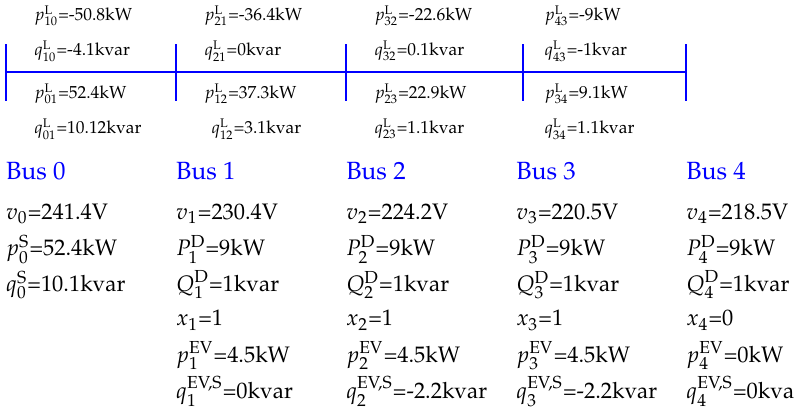
Figure 4. Illustrative example: Results of problem (P1) with reactive power droop